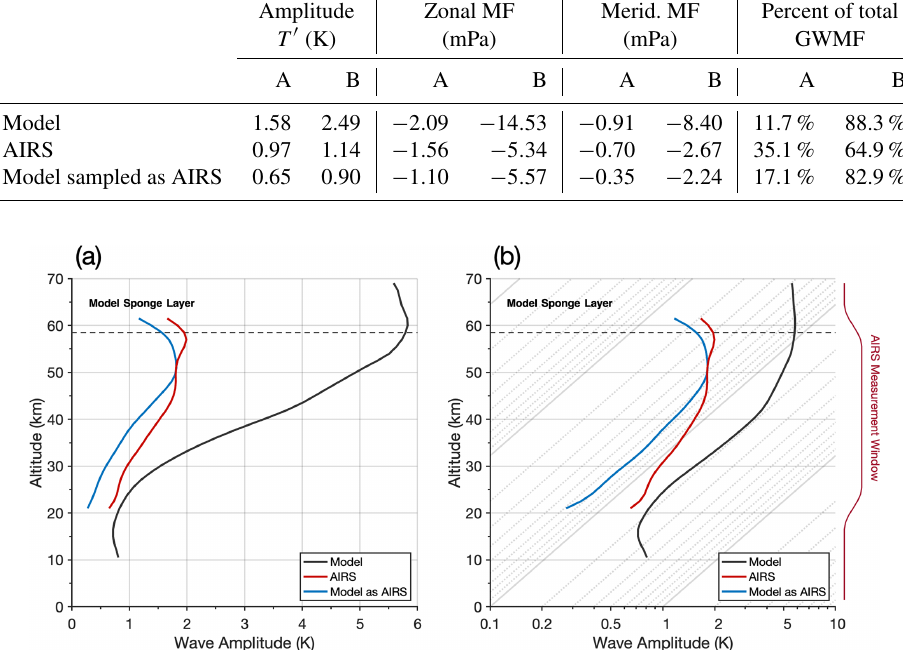
Figure 10. Vertical profiles of the average measured wave amplitudes over South Georgia in AIRS observations (red), the full-resolution model (black) and the model sampled as AIRS (blue) for June–July 2013 and 2015. Values are averaged over a horizontal area 600 × 400km centred on the island (region C in Fig. 4). Both (a) and (b) show the same data, but in (b) the data are plotted on a logarithmic x axis where thin grey diagonal lines show the exponential adiabatic growth rate of GW amplitude with altitude e atmospheric scale height of H = 7km. The model damping “sponge” layer (dashed black line) begins at z = 58 . 5km and extends to the model